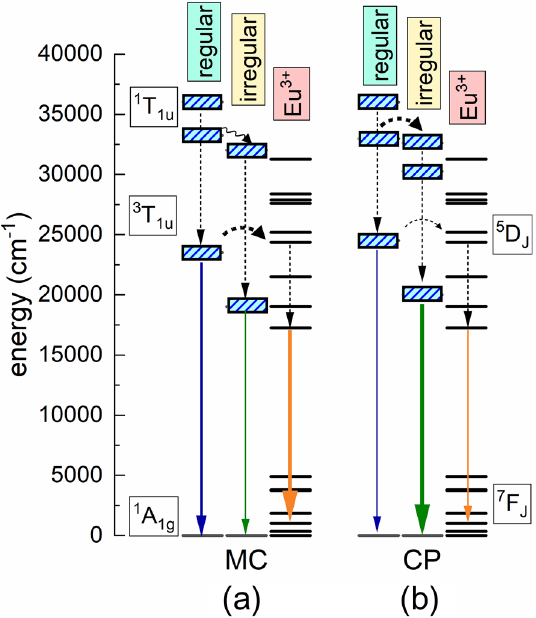
Figure 4. Energy scheme of regular and irregular WO 6 groups, Eu 3+ and the energy transfer processes, emissions, and nonradiative transitions occurring in BMW: Eu 3+ samples. The line thicknesses represent process intensity. Dashed and wavy lines represent nonradiative transitions, while solid straight lines represent radiative ones. Please note that the energy transfer to Eu 3+ only comes from regular WO 6 groups—see text for